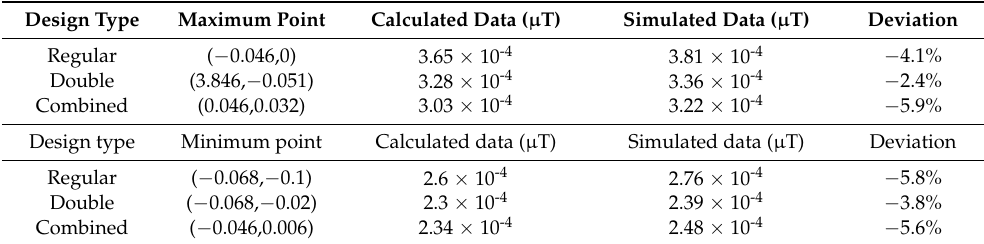
Table 2. Comparison of calculated and simulated data.